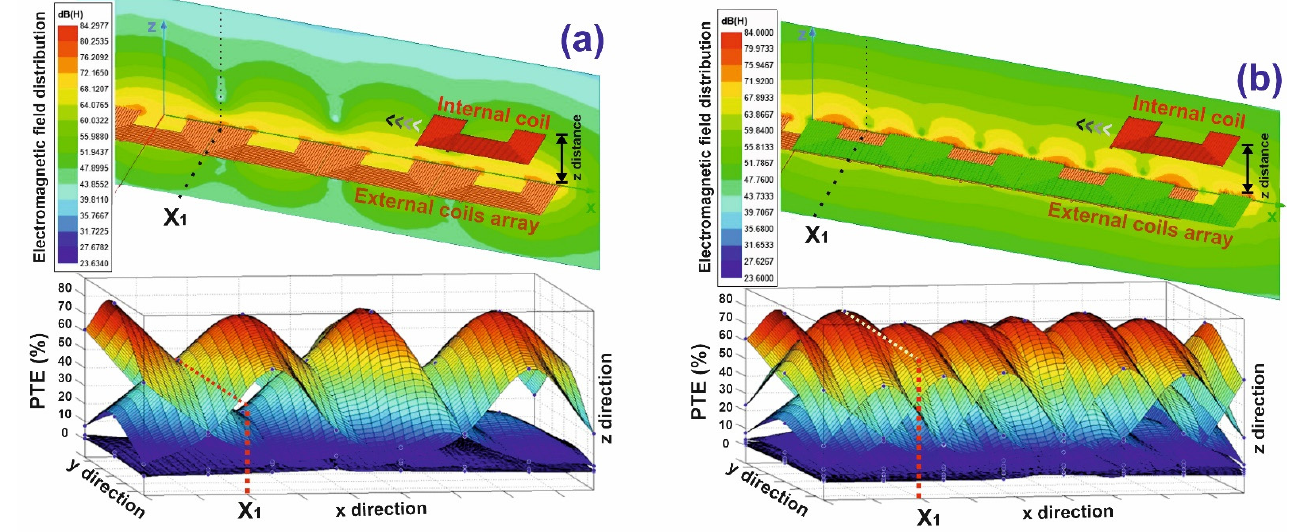
Figure 8. Electromagnetic field distribution and power transfer efficiency for ( a ) non-overlapped and ( b ) overlapped structures.